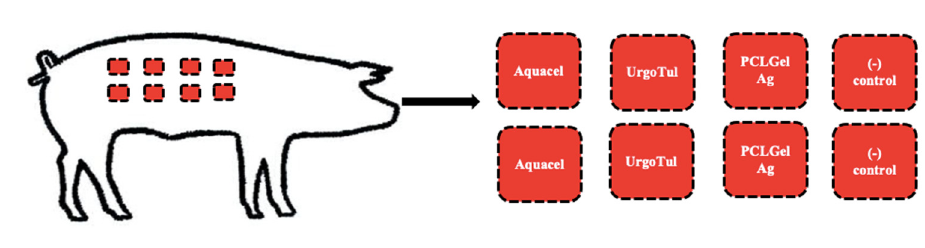
Figure 2. The schematic of burn wound treatment in the porcine model .